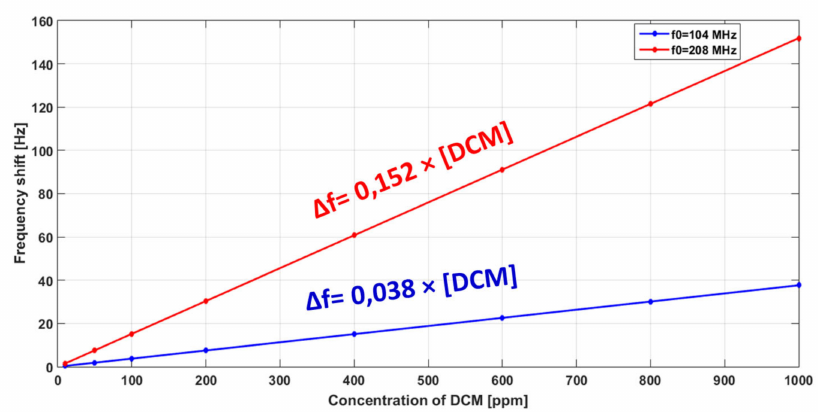
Figure 8. Sensitivity curves for 104 and 208 MHz SAW gas